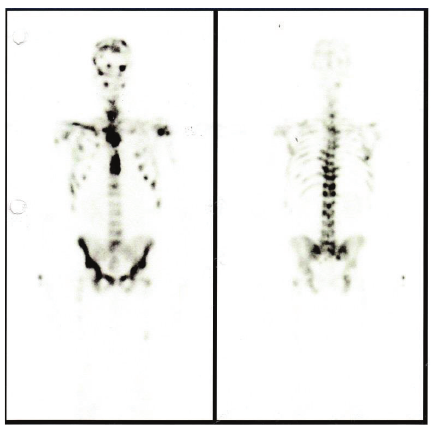
Figure 3: Tc-99m body scan revealing multiple skeletal lesions, confirming the previous tomography suspicion of axial, sternum, and cranium bone metastasis.